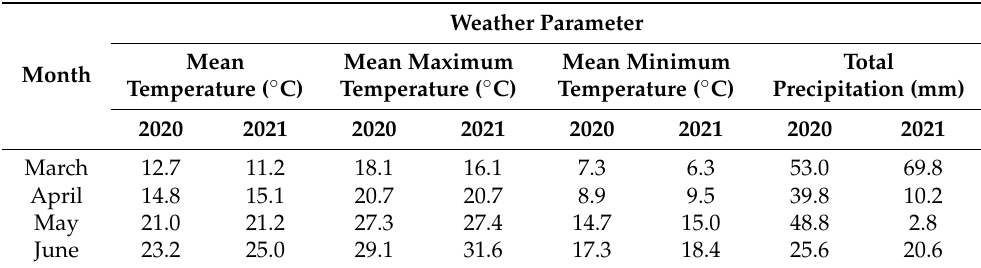
Table 1. Mean, mean maximum, and mean minimum monthly temperature ( ◦ C) and total monthly precipitation (mm) values observed in the experimental